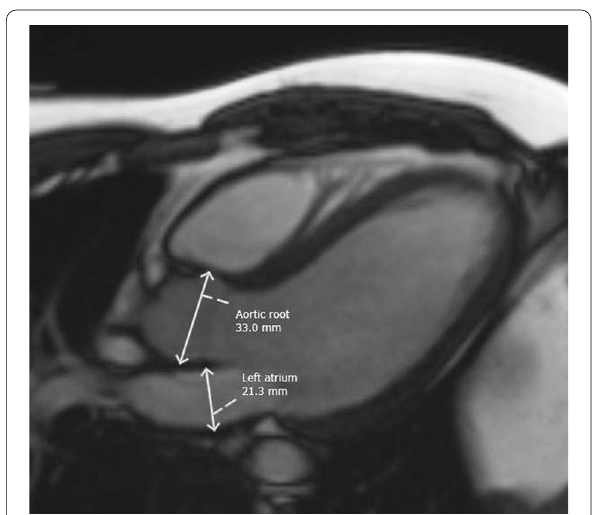
Fig. 2 The method of measuring LA and Ao in a 3-chamber CMR